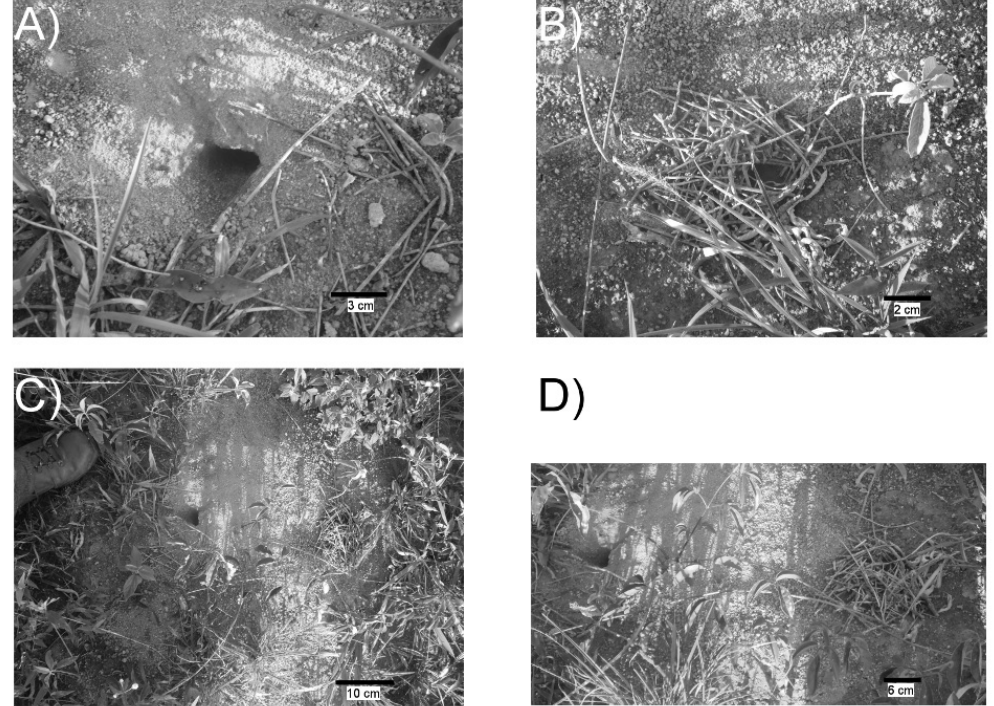
Fig 2 . Nest of Atta used by Dinoponera quadriceps . A) Atta entrance; B) Dinoponera quadriceps entrance; C) and D) the entrances sight